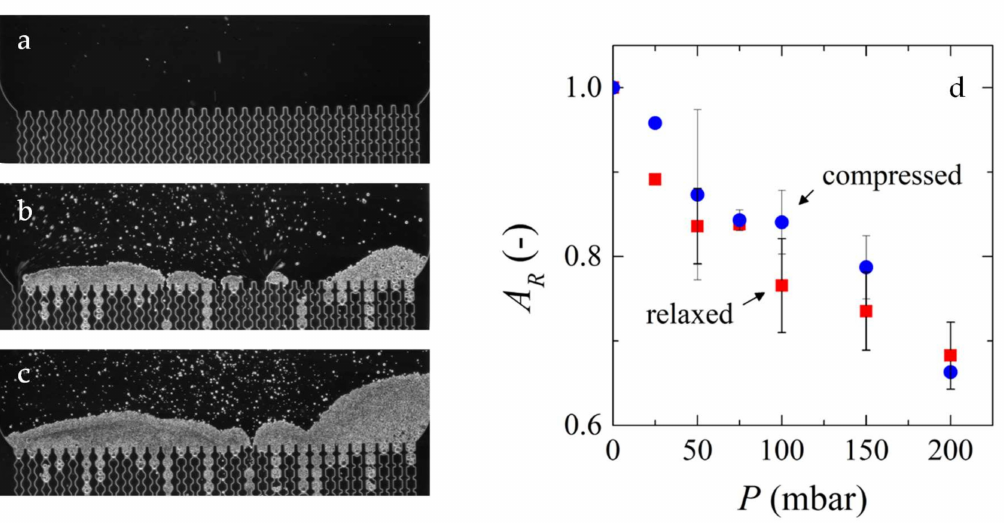
Figure 5. Microscopy images of a deposit layer formation on top of a membrane mimic microfluidic device ( a ) before clogging, and ( b ) in the middle and ( c ) end of the filtration process. ( d ) variation of relative cake area with varying pressure for filtration cakes being compressed (blue circles) and relaxed (red squares) [30]. Image d) has been reproduced under the Creative Commons Attribution